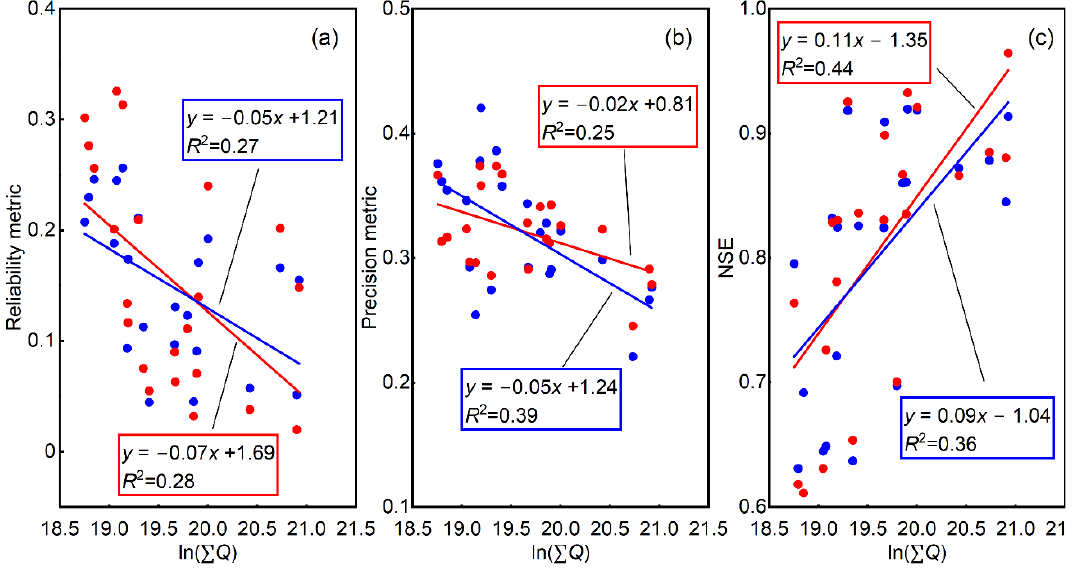
Figure 12. Comparison of the predictive performance of the ‘KA’ and ‘KF’ scenarios under different total flood volume: ( a ) scatter plot of the reliability metric; ( b ) scatter plot of the precision metric; ( c ) scatter plot of the NSE S . Fitted linear trends and corresponding R-squared values are also shown. Blue markers and lines represent the ‘KA’ scenario, while red markers and lines represent the ‘KF’ scenario. The natural logarithm is implemented to the flood volume to strengthen the linear trends.